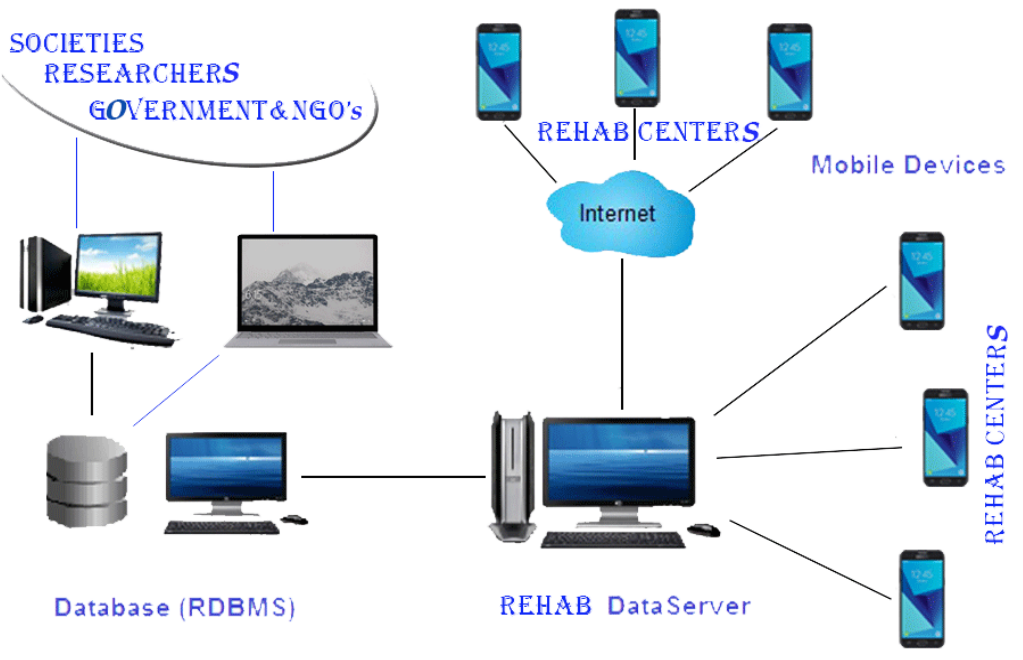
Figure 5. The designed